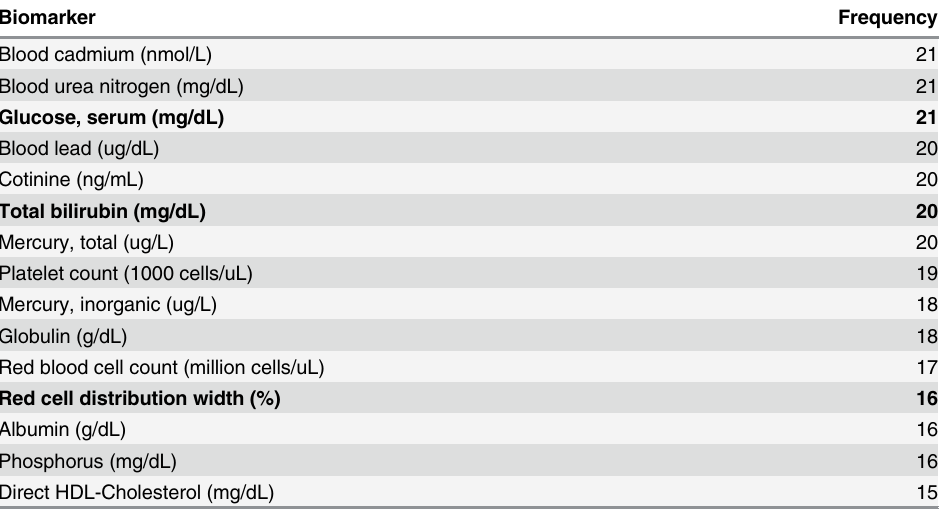
Direct HDL-Cholesterol (mg/dL) 15 Note: Bold represents the fi nal 3 biomarkers selected from proposed